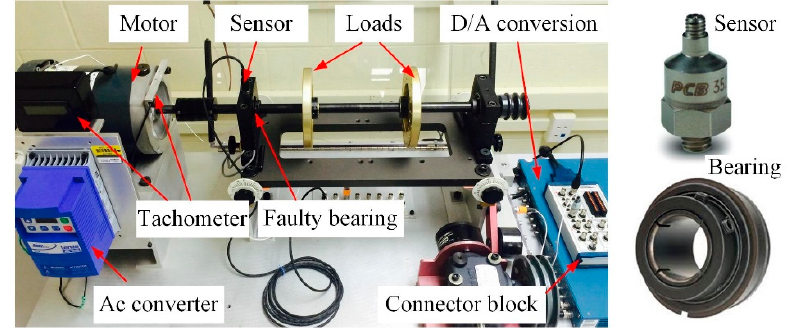
Figure 16. Experimental set-up, a sensor and a bearing.